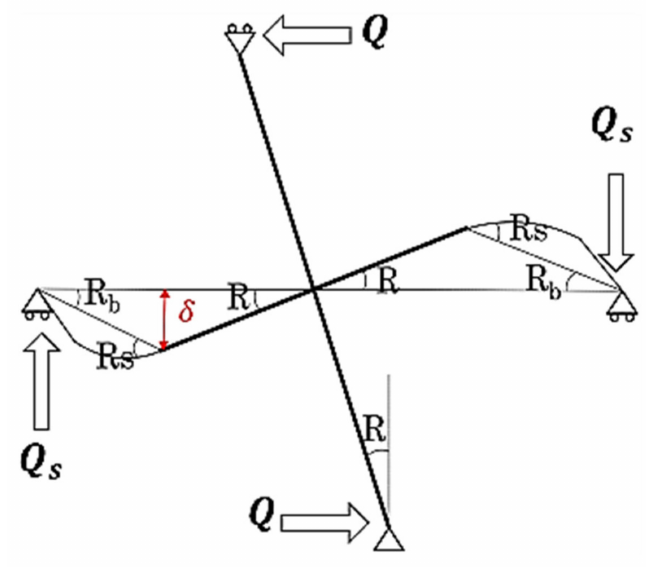
Figure 11. Calculation